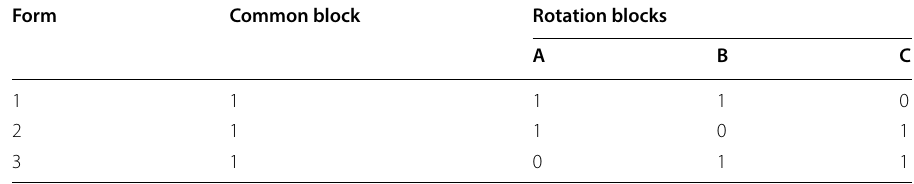
Table 2 Three-form design based on PISA 2012 Form Common